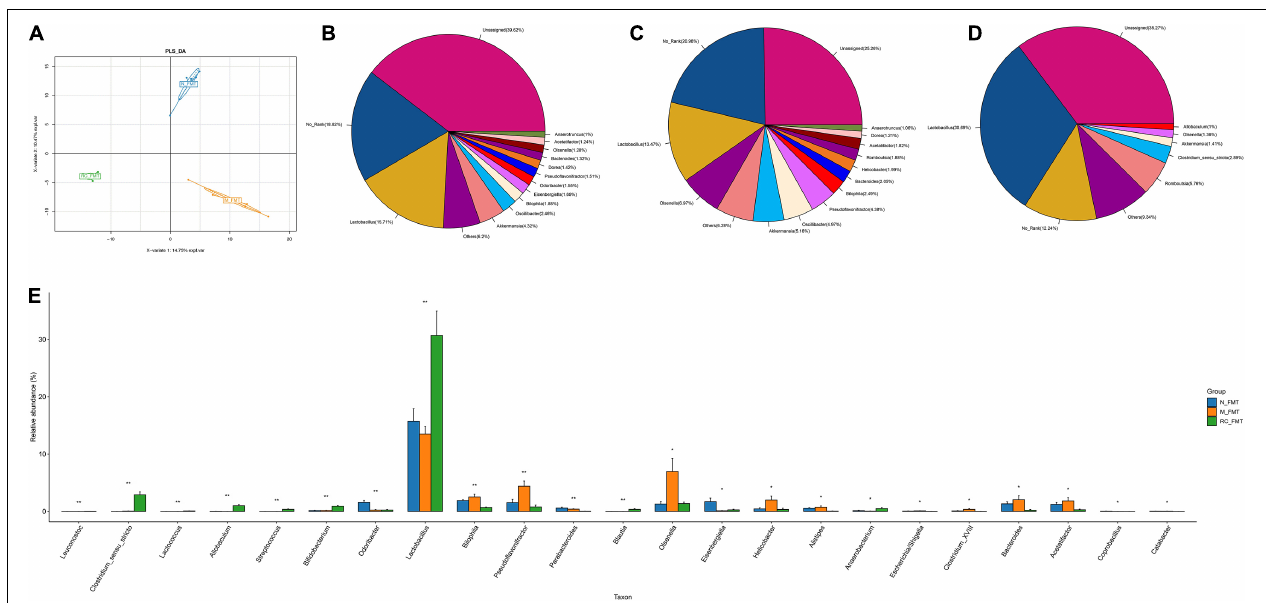
FIGURE 6 | The effects of FMT on GM diversity and abundance in DM mice. (A) The differences in community composition studied using PLS-DA. (B–D) Pieplot of relative GM abundance at the genus level. (E) A histogram showing GM abundance at the genus level. Data are expressed as mean ± SD. * P < 0.05; ** P < 0.01; n =